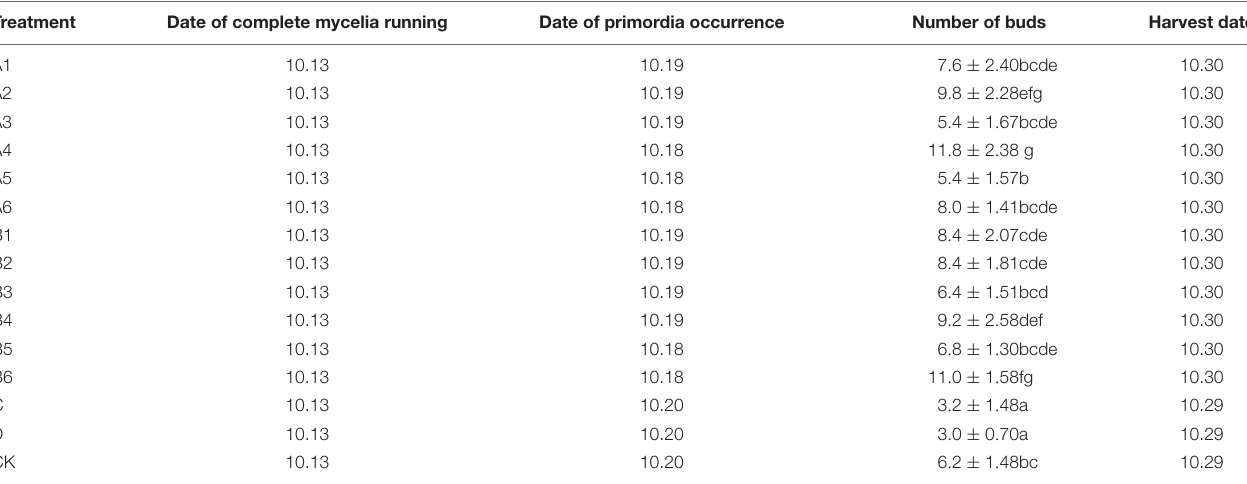
TABLE 2 | Comparison of emergence time of primordia and number of buds under different treatments.